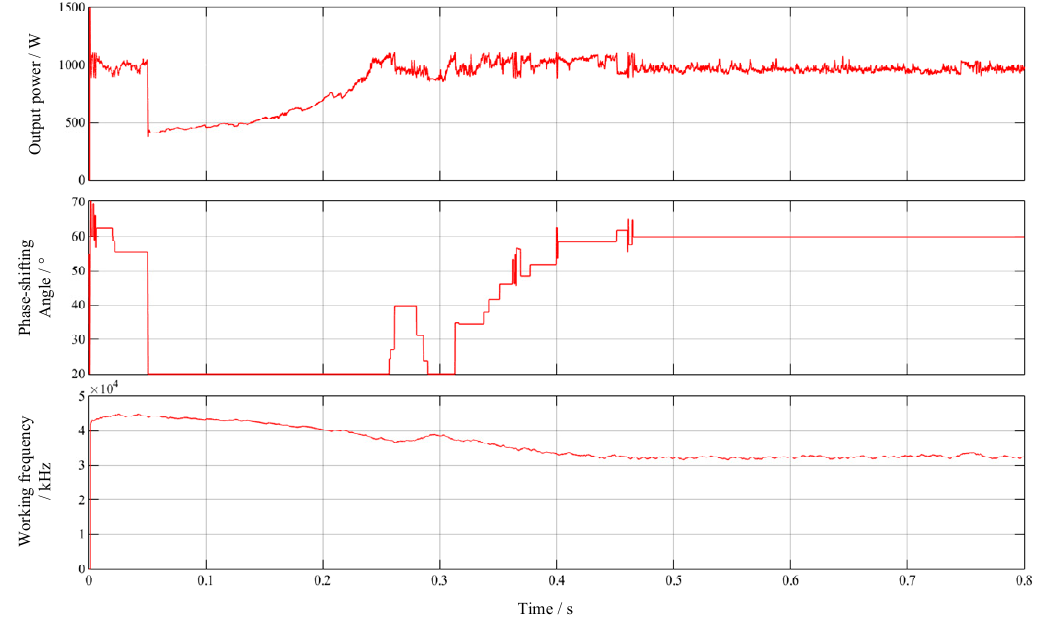
Figure 16. Anti-perturbation waveform of load capacitance surge.